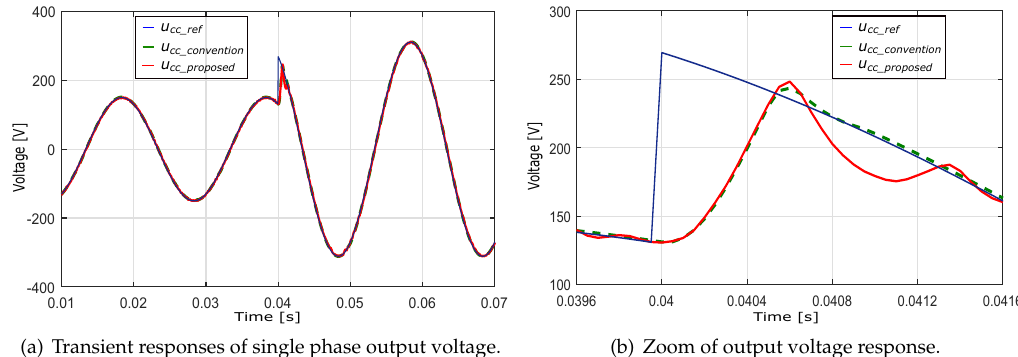
(b) Zoom of output voltage response.